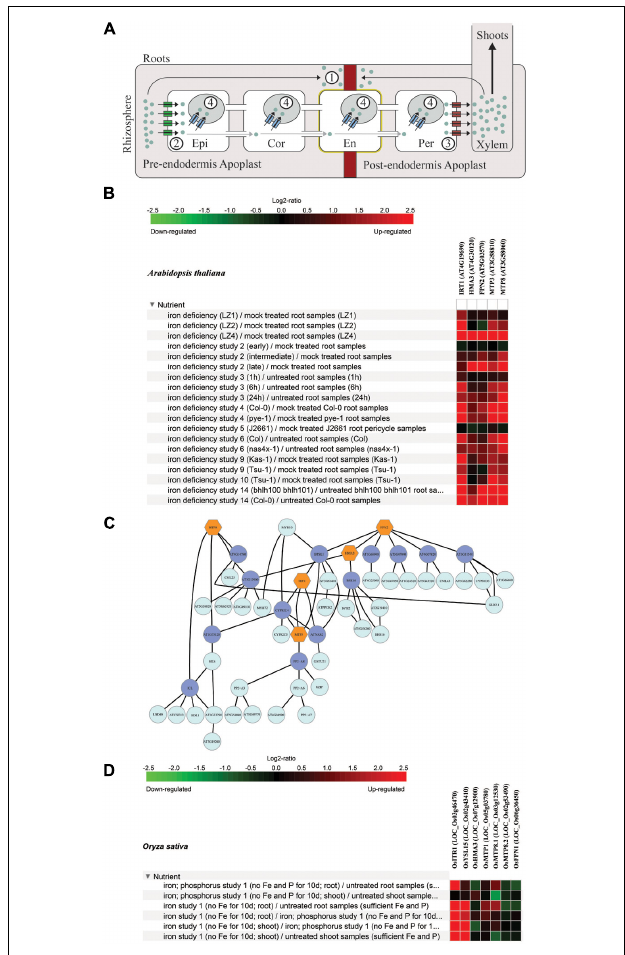
FIGURE 1 | Root vacuolar compartmentalization regulating the ionome. (A) Checkpoints of ion radial movement within roots. (1) Endodermal diffusion barriers block ions entry in the apoplast connected to the xylem. (2) Influx and (3) efflux transporters control ion concentration in the root symplast. Influx and efflux transporters may also be present in plasma membranes of other cells, but are shown in epidermis and pericycle for clarity. (4) Root vacuoles can restrict symplastic movement of ions, and therefore decrease or increase their availability for xylem loading and shoot/seed translocation. Different cell layers may have distinct vacuolar repertoire for storage. Gray arrows indicate diffusion within the symplast through plasmodesmata. Epi, epidermis; Cor, cortex; En, endodermis; Per, pericycle. Red band – Casparian Strip; yellow = suberin deposition. (B) Data from Genevestigator showing regulation under Fe deficiency of Arabidopsis genes AtIRT1 (AT4G19690), AtHMA3 (AT4G30120), AtFPN2 (At5G03570), AtMTP3 (AT3G58810), and AtMTP8 (AT3G58060). (C) Graphical visualization of the coexpressed gene network of the same genes as in (B) using ATTED-II (http://atted.jp/). Nodes (hexagons and circles) represent genes, while straight lines represent coexpression. Nodes in hexagonal shape and orange color represent genes of interest. Nodes in circle shape and purple color represent genes within the network which are directly connected to the genes of interest. Nodes in circle shape and light blue color represent genes which are connected to the purple circle genes. (D) Data from Genevestigator showing regulation under Fe deficiency of rice genes LOC_Os03g46470 ( OsIRT1 ), LOC_Os02g43410 ( OsYSL15 ), LOC_Os07g12900 ( OsHMA3 ), LOC_Os05g03780 ( OsMTP1 ), LOC_Os03g12530 ( OsMTP8.1 ), LOC_Os02g53490 ( OsMTP8.2 ), and LOC_Os06g36450 (not yet characterized, but most similar gene to AtFPN1 / AtFPN2 ; named OsFPN1